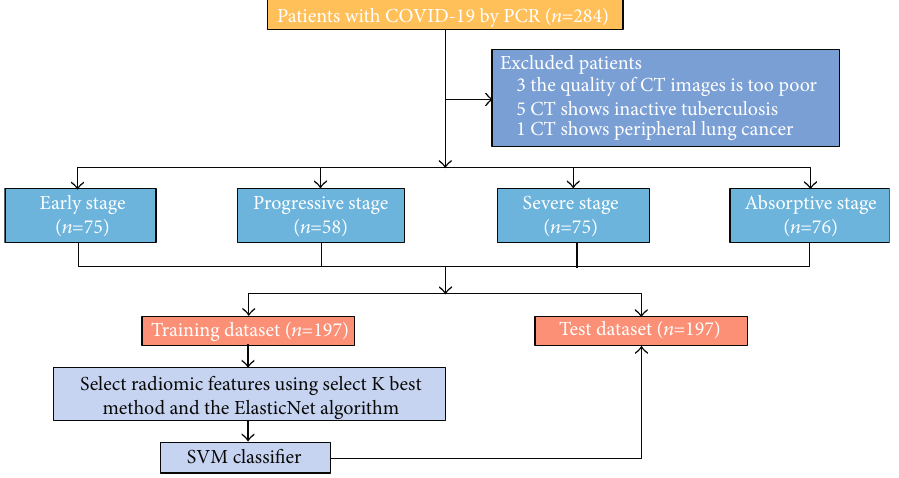
Figure 5: Flowchart through the